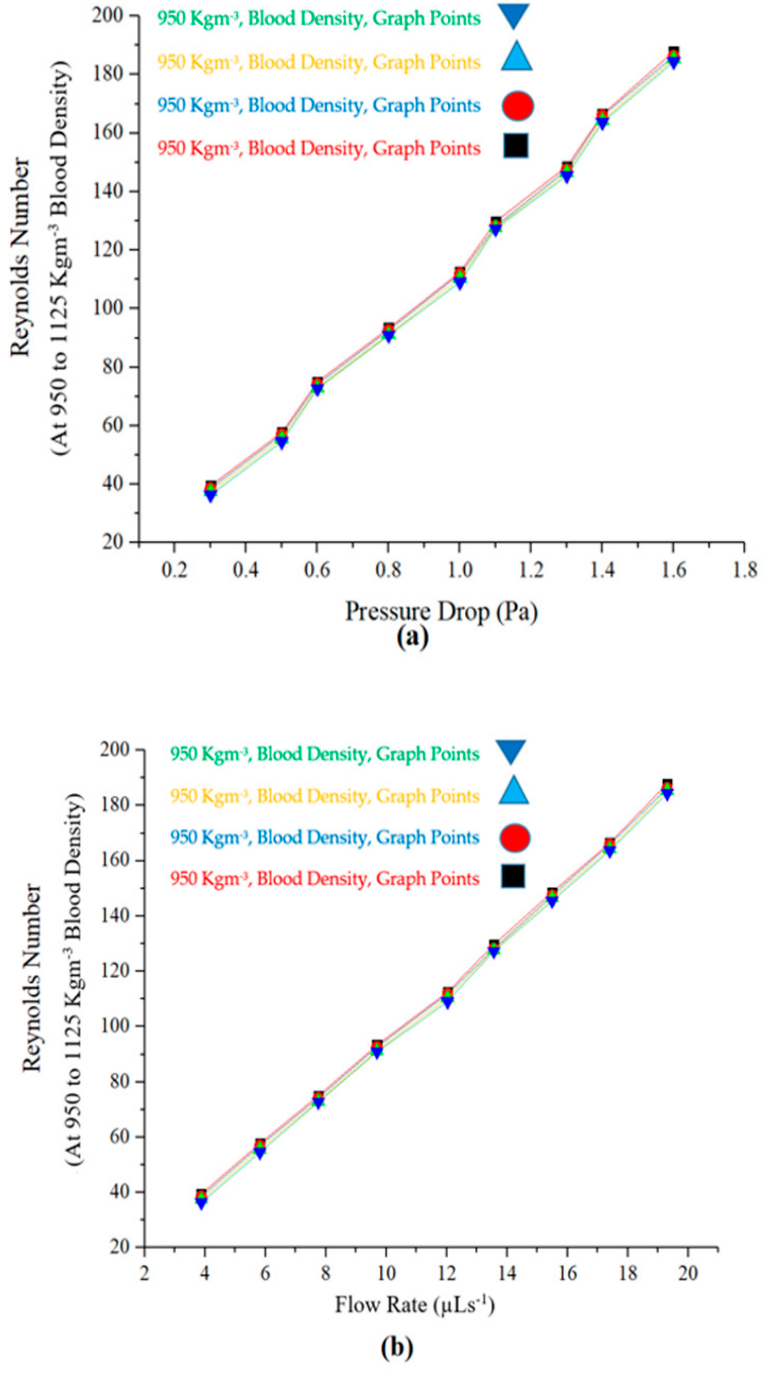
Figure 12. ANSYS Fluent Simulation graphs for 5CACMC ( a ) Reynolds number and pressure drop ( b ) Reynolds number and flow rate.